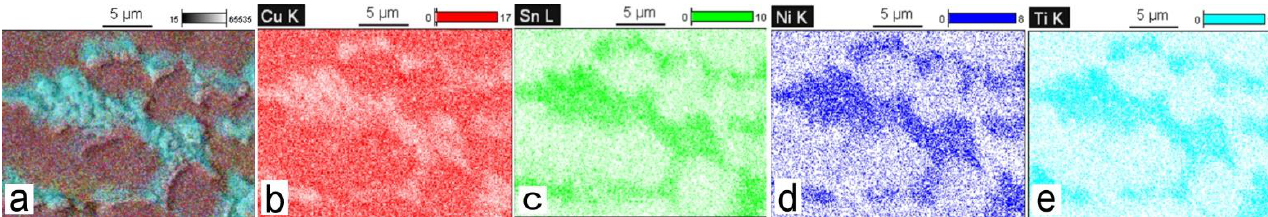
Table 6. Chemical composition EDS wt.% of CuSn8Ni3Ti0.2 alloy for the Figure 6c image.